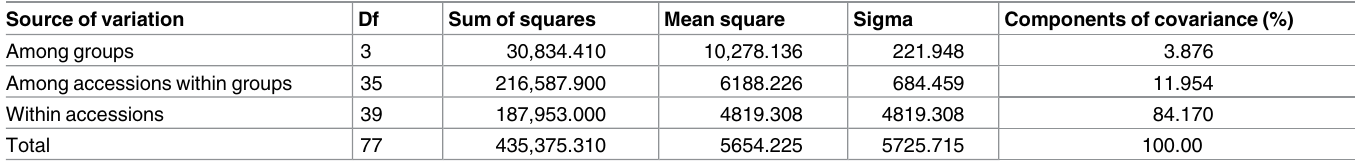
Table 8. AMOVA of the sweet potato core